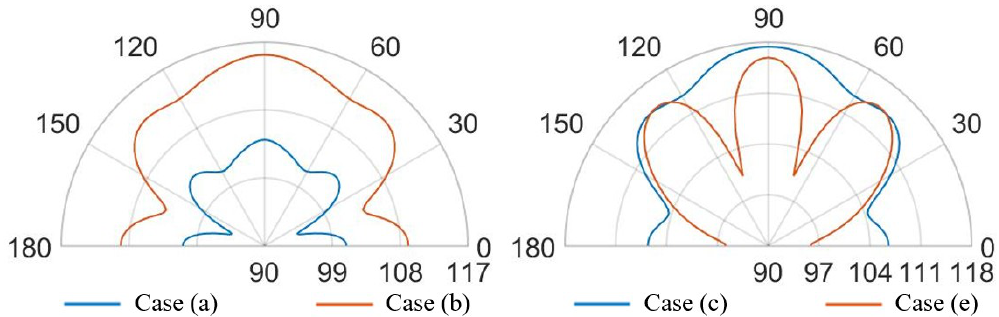
Figure 30. SPL polar plot (dB) at the performing fundamental frequency of 93.0 kHz (3 V bias), at 3.5 cm in the y(90 ◦ )–z(0 ◦ ) plane: (a) vs (b) ( left ), (c) vs (e) ( right